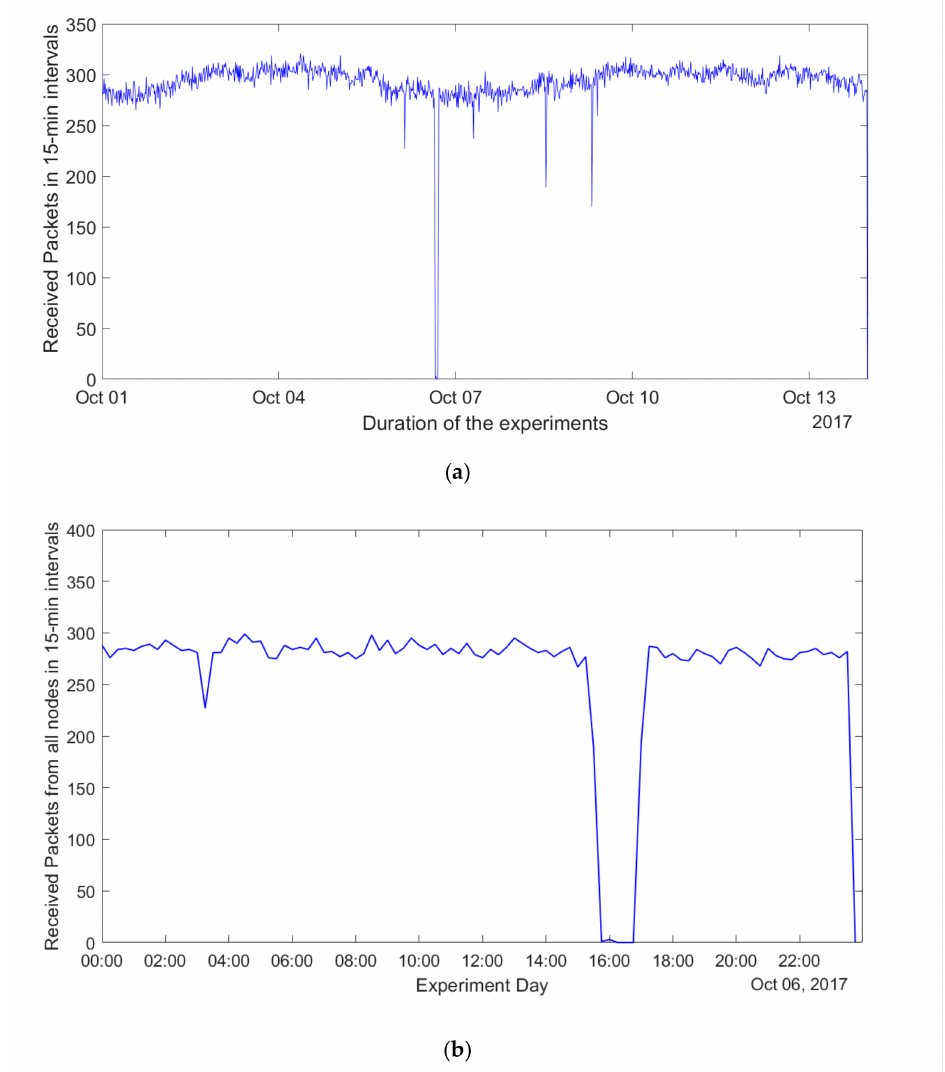
Figure 5. Packet reception by the IoT server. ( a ) Number of packets received in a 15-min interval from all nodes from 1 October to 14 October 2017. ( b ) Number of packets received in a 15-min interval from all nodes on 6 October